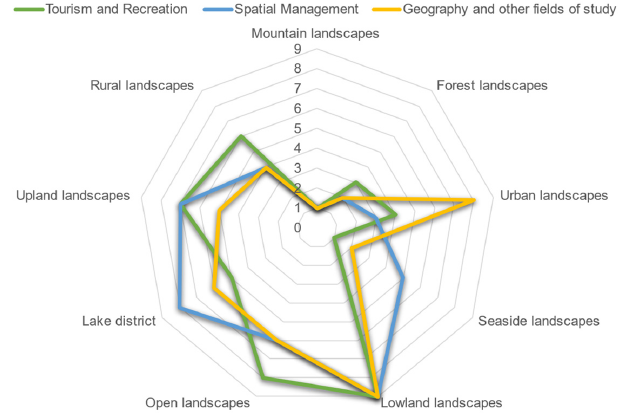
Figure 4. Landscape preferences. 1—The most frequently chosen landscapes; 9—the less frequently chosen